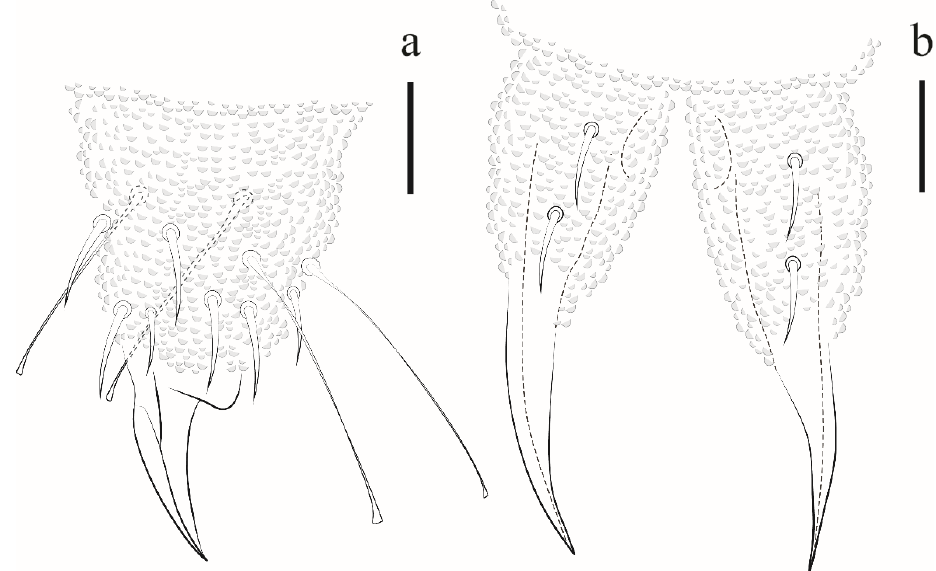
Figure 17. Paraxenylla zeliae sp. nov . ( a ) Tita III, scale bar: 20 µm. ( b ) mucrodens, scale bar: 20 µm. Table 7. Morphological characters of Paraxenylla Murphy, 1965 species recorded from Brazil. VT—ventral tube